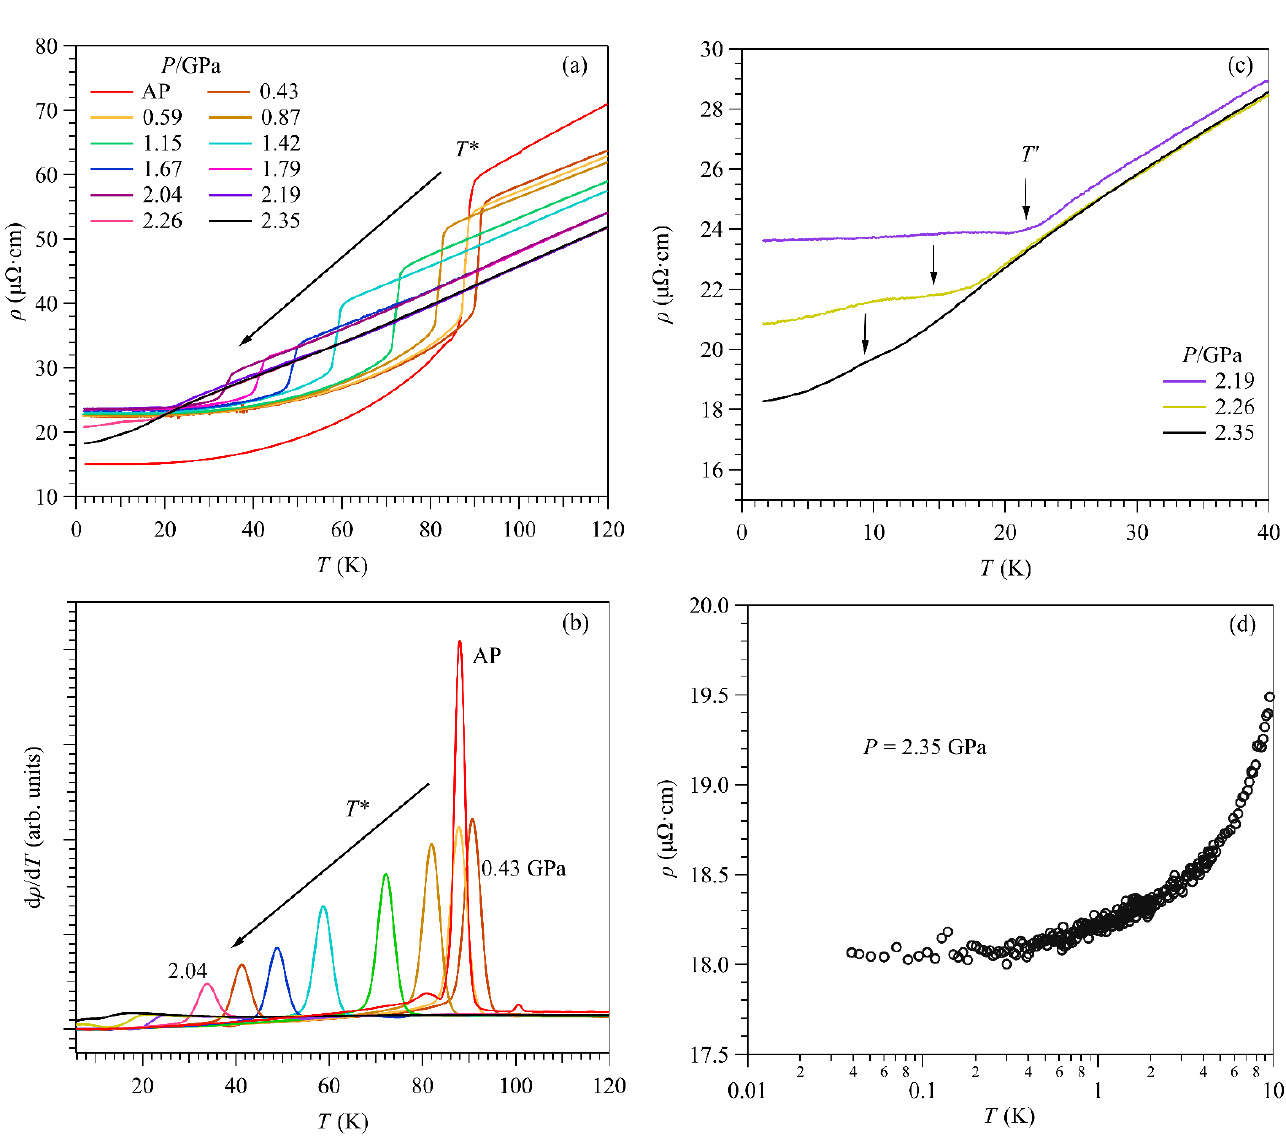
Figure 2. ( a , b ) Temperature dependence of resistivity ρ ( T ) and its derivative d ρ /d T for ScV 6 Sn 6 measured in the piston-cylinder cell under various pressures up to 2.35 GPa. The CDW transition temperature T* is determined from the peak of d ρ /d T as shown in ( b ). ( c ) Magnification of low-temperature ρ ( T ) data in the pressure range 2.19–2.35 GPa. ( d ) Resistivity down to 40 mK at 2.35 GPa.